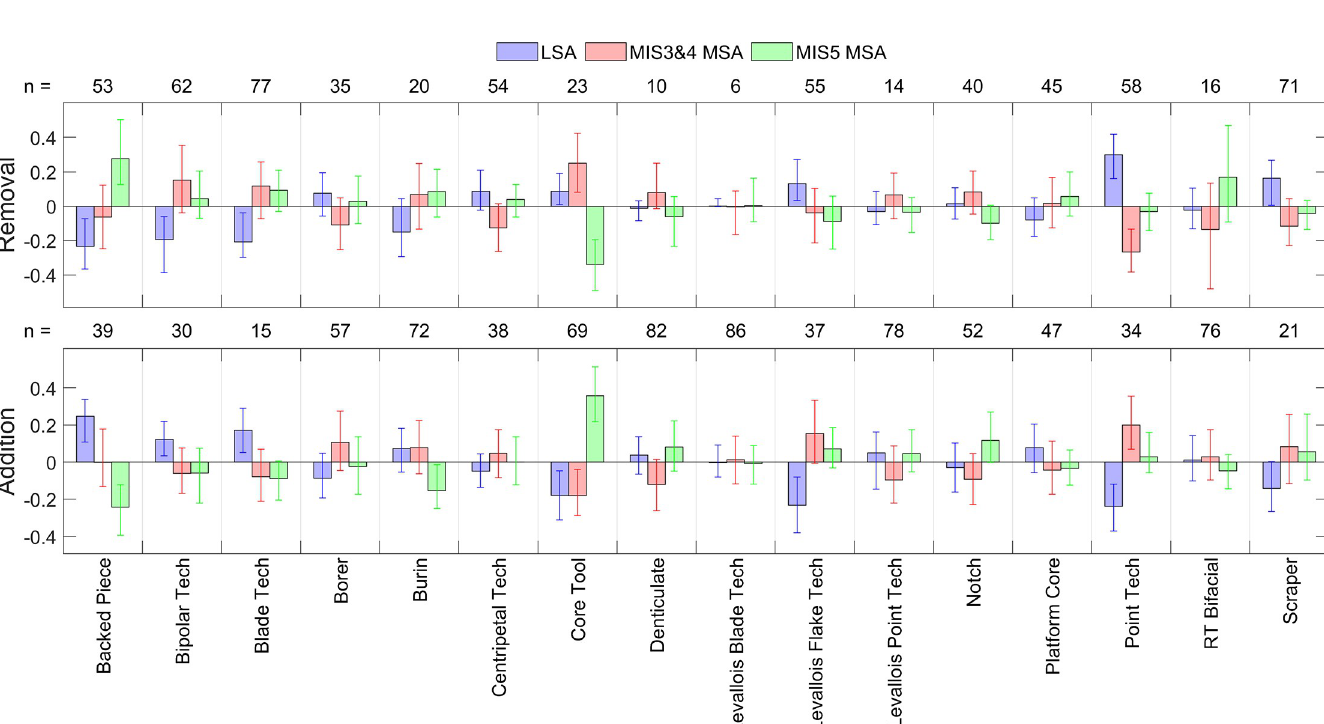
Levallois flakes. Levallois flake technology is present in all assemblage classes at relatively high frequencies: 26% in LSA, 71% in MIS3&4 MSA, and 83% in MIS4&5 MSA assemblages, with an overall percentage in the whole dataset of 60%. The 3-way ANN analyses extract it as a